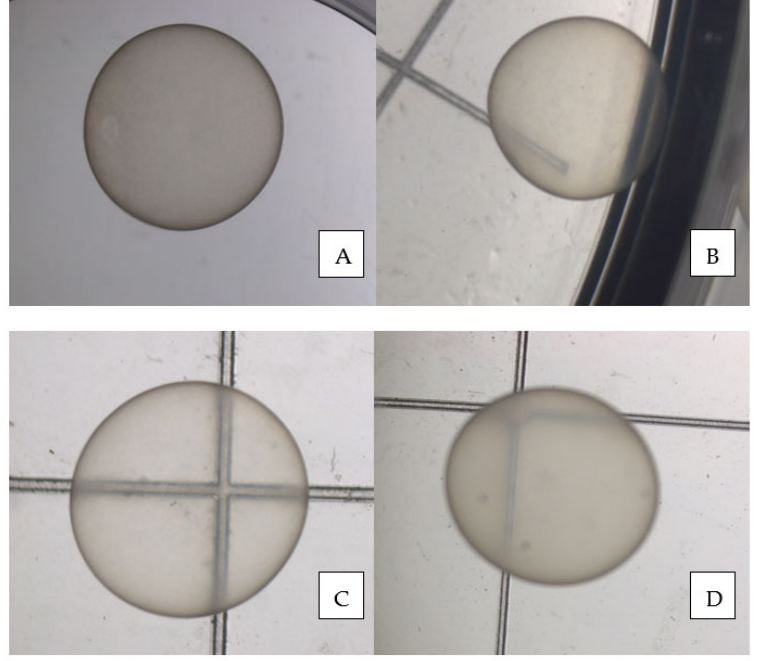
Figure 2. Grade 1 horse ( A ), donkey ( B ), mule ( C ), and hinny ( D ) day 11–12